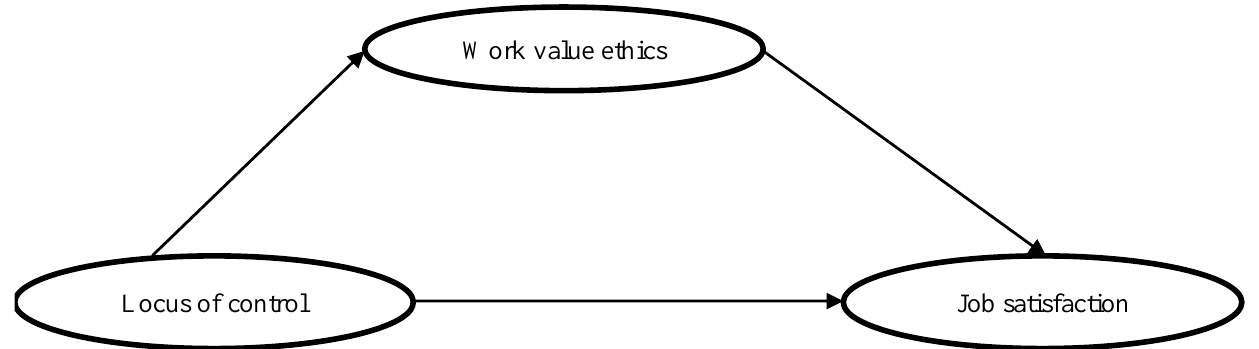
Figure 1. Research model: locus of control, work values ethic, and job satisfaction.